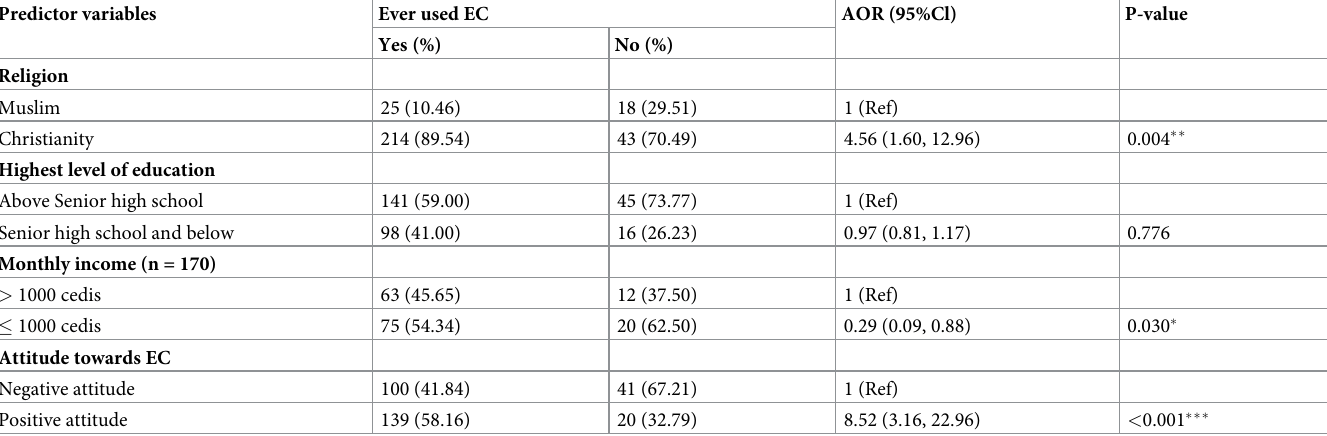
Table 6. Multiple regression analysis of factors influencing emergency contraception usage among the women in the Kwadaso Municipality. Predictor